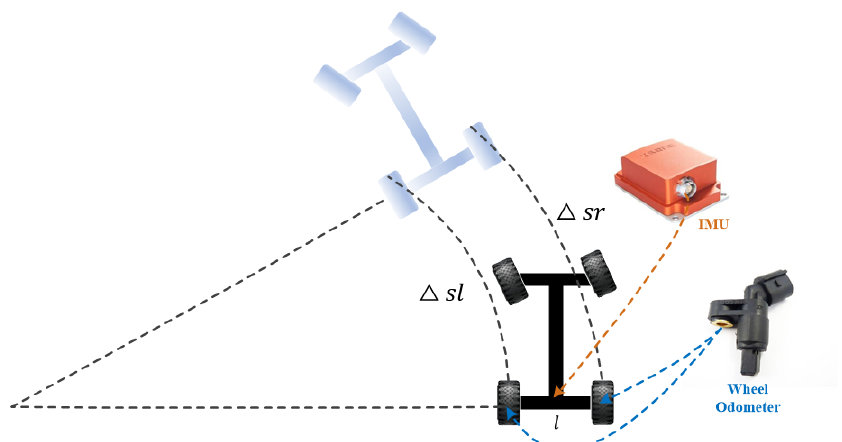
Figure 4. Schematic diagram of the simplified vehicle motion model. The black car represents the previous position of the vehicle, and the blue car indicates its current position. During a time period, the left rear wheel travels a distance of (cid:52) sl , and the right rear wheel travels (cid:52) sr . By assuming the angular velocity of the IMU constant during [ t B from t B to t B and solve the differential equation. The rotation matrix R BW k − 1 k